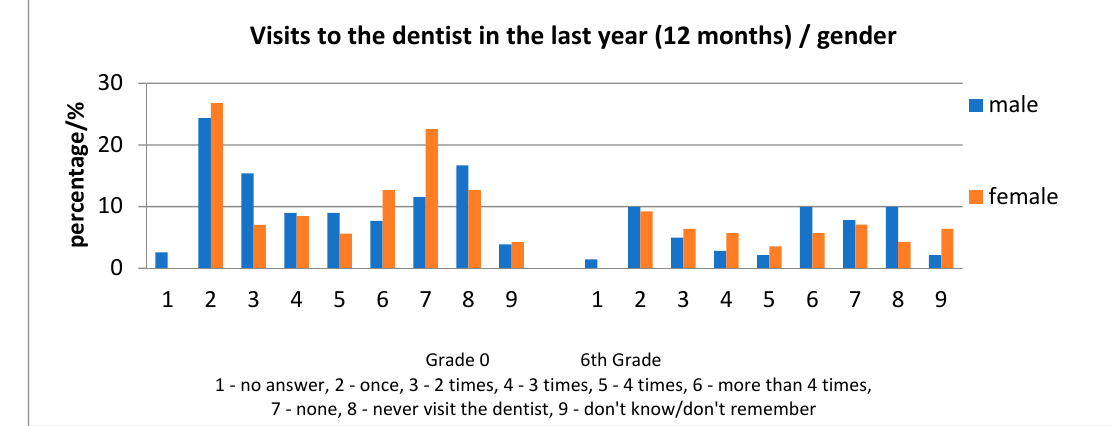
Figure 3. Differences of the number of visits in the dental office for the last year, according to Figure 3. Di ff erences of the number of visits in the dental o ffi ce for the last year, according to gender. Int. J. Environ. Res. Public Health 2020 , 17 , x FOR PEER REVIEW gender.